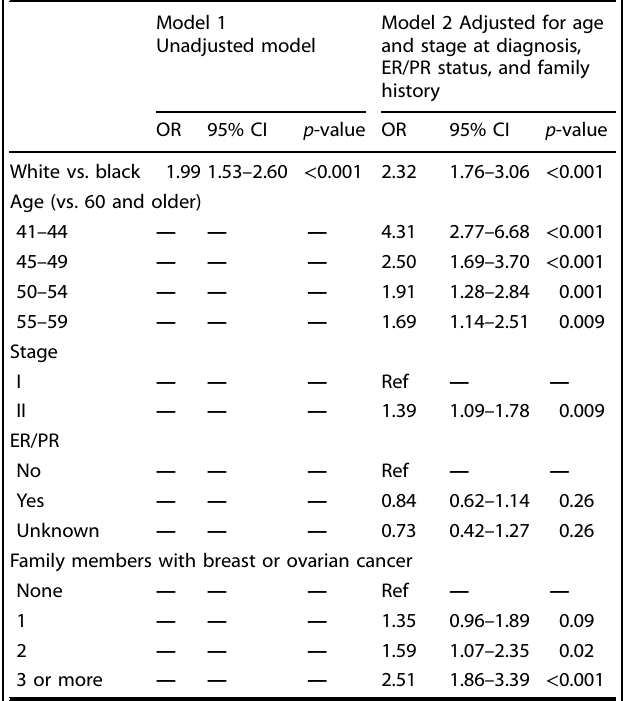
Table1. Characteristics of study participants by race ( N = 2182) Black